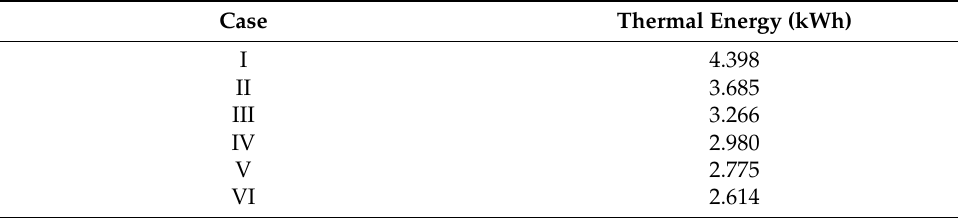
Table 4. Daily thermal energy produced by the DSF system for each of the studied cases.